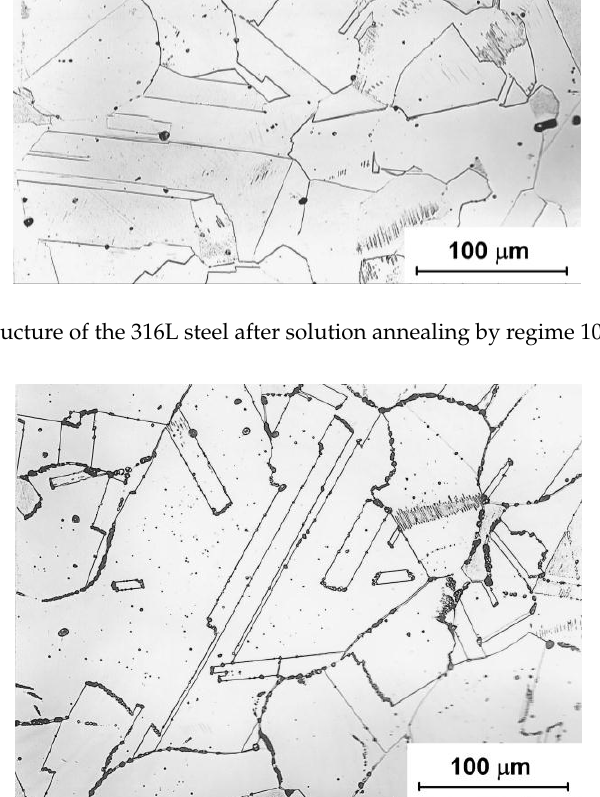
Figure 2. Microstructure of the 316L steel after solution annealing by regime 1050 °C/1 h/water and stabilization annealing by regime 850 °C/4 h/water.